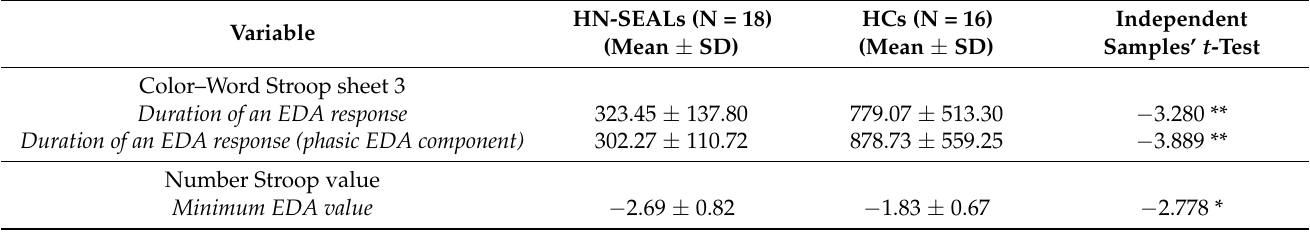
Table 5. Independent sample t -test of electrodermal activity mean values during cognitive tasks in HN-SEALs and HCs.